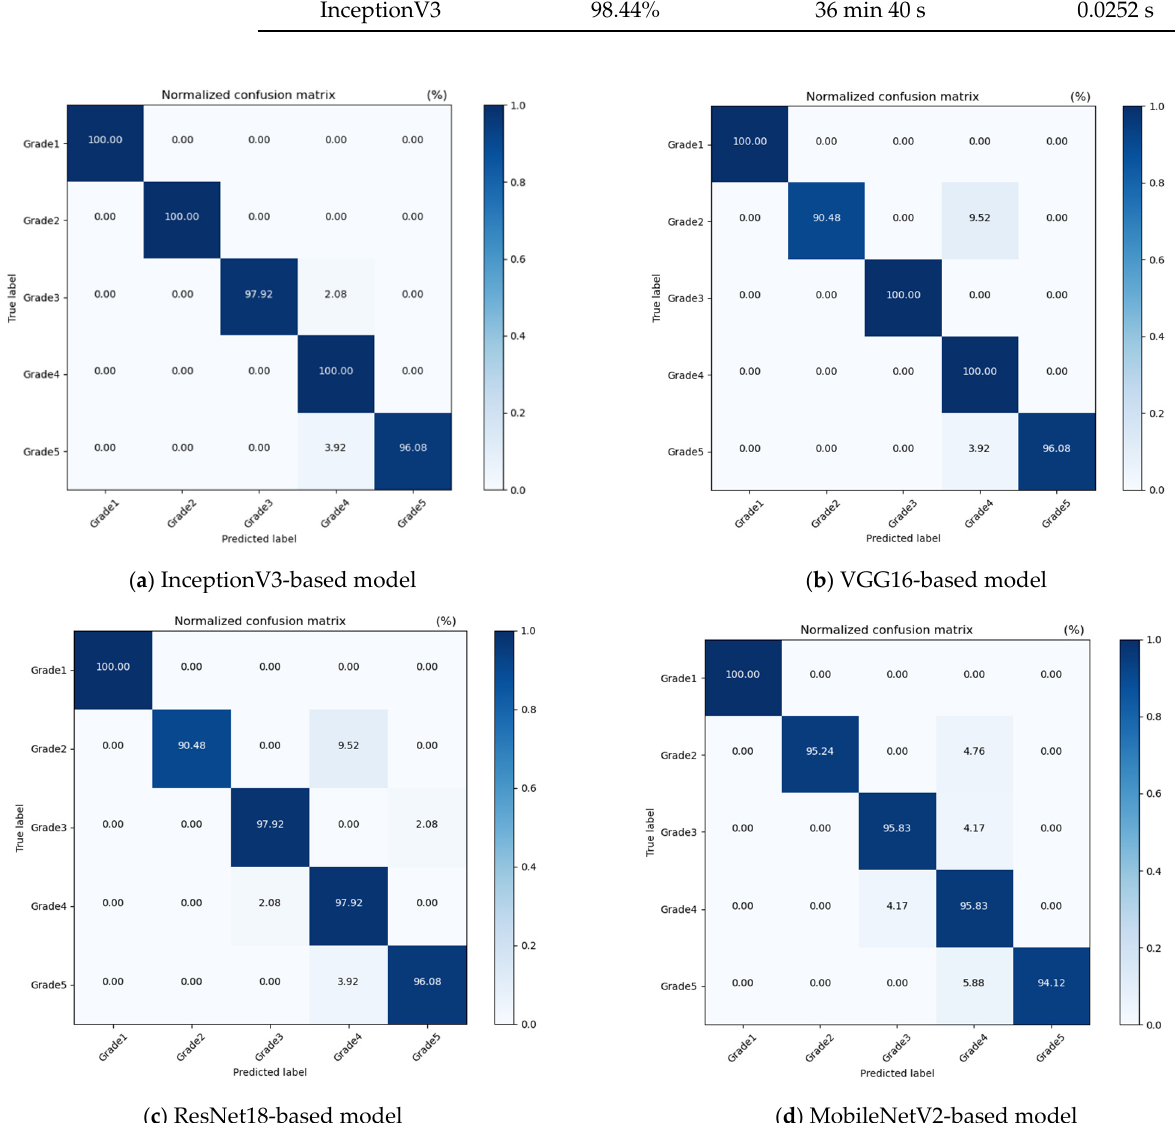
Figure 9. Confusion matrix of the improved InceptionV3-based model using RGBD data.